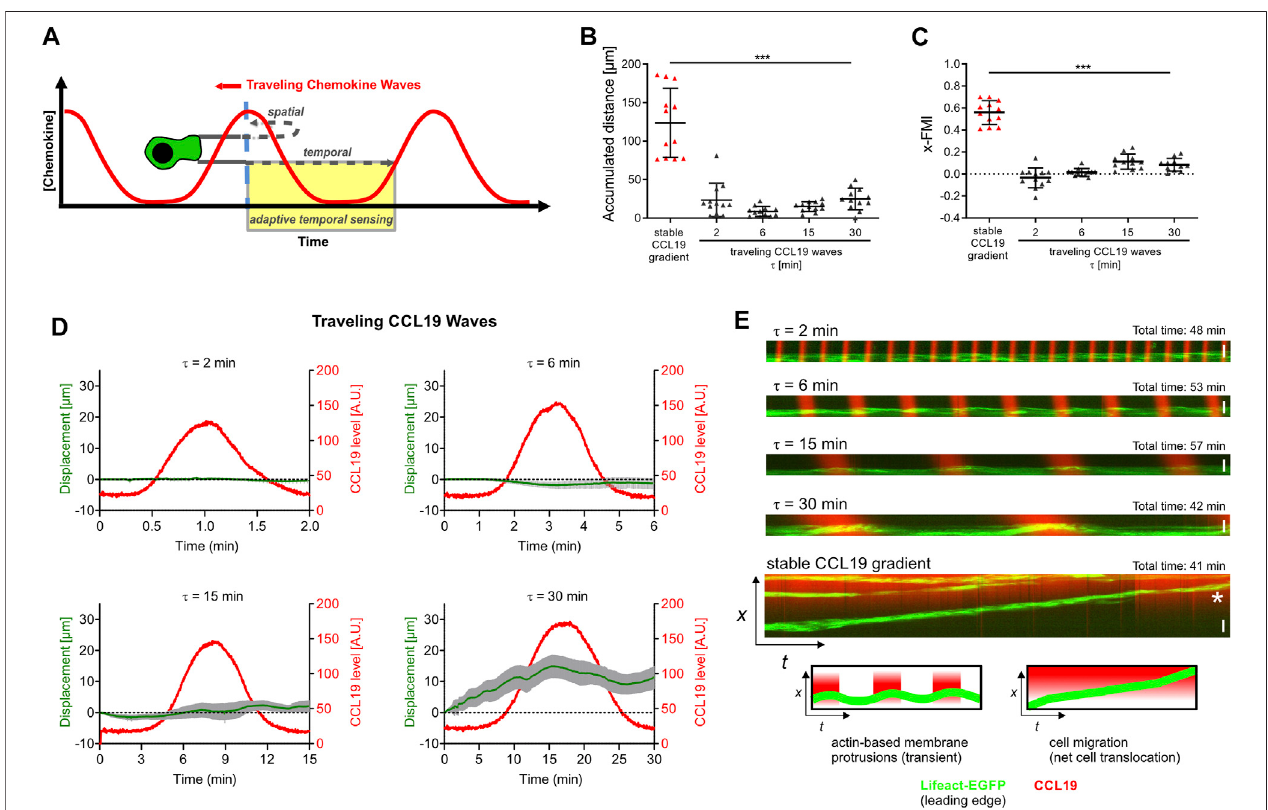
FIGURE6 | BM-DCs arenot able todecode oscillatory stimulation of soluble CCL19 traveling waves intoa directional chemotactic response. (A) Proposed model of spatial and temporal sensing behavior in traveling waves of chemoattractant, modi fi ed after (Nakajima et al., 2014; Skoge et al., 2014). (B,C) Analysis of BM-DC migration for 60 min exposed to stable soluble CCL19 gradients or traveling CCL19 waves with various periods ( τ = 2 – 30 min), including (B) accumulated distance and (C) x-Forward Migration Index (x-FMI) of individual cells. Representative data from one of eight experiments; triangles represent randomly chosen cells per condition, N = 12, mean ± SD. (D) X-displacements of BM-DCs over 60 min migration towards the source of soluble traveling CCL19 waves with various periods ( τ = 2 – 30 min). Representativedata from oneofeightexperiments withrandomlychosencells per condition, N =12, mean ±SEM. (E) High resolution kymographic analysis of actin dynamics of Lifeact-EGFP expressing BM-DCs which are exposed to traveling CCL19 waves with various periods ( τ = 2 – 30 min) or soluble stable CCL19 gradients, respectively. Actin dynamics of individual cells was analyzed by kymograph and line scan analysis of yellow lines (indicated in Supplementary